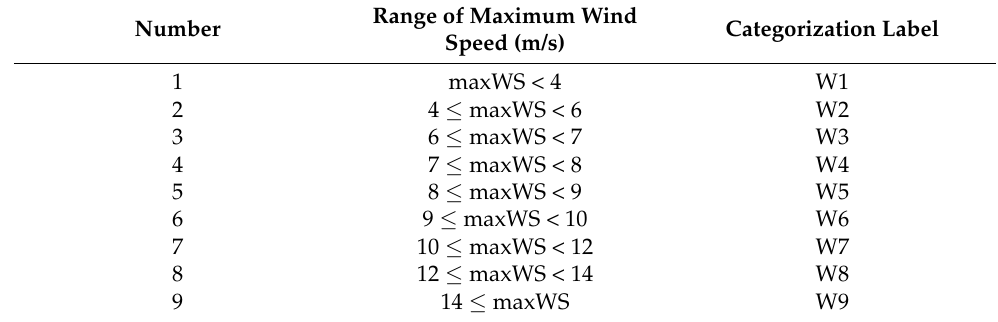
Table 6. Classification of maximum wind speed (maxWS).